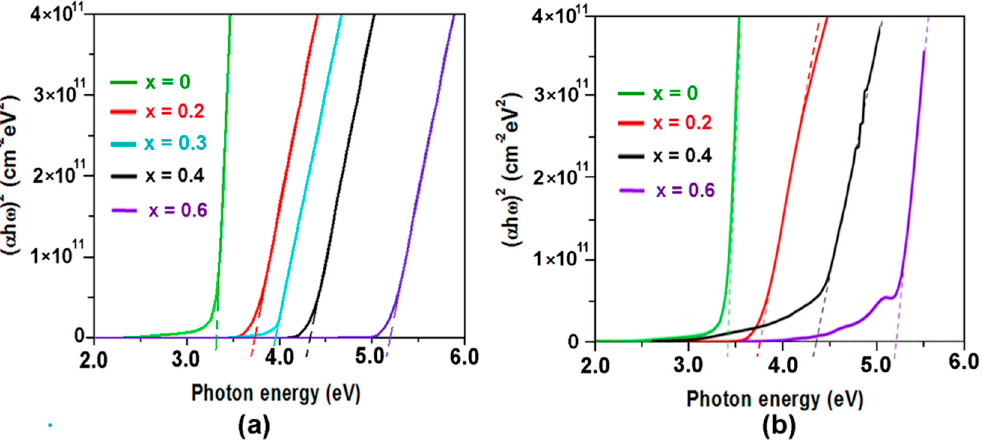
Figure 9. Tauc plot of optical absorption spectra measured at room temperature for Zn 1-x Mg x O films deposited on quartz substrates by spin coating ( a ) and aerosol spray pyrolysis ( b ).